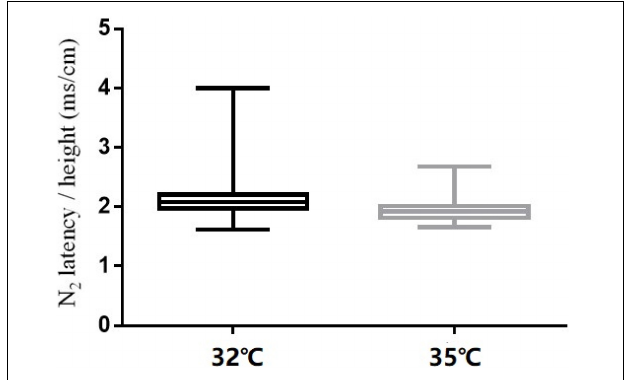
FIGURE 4 | N 2 latency/height at the right forearm for different baseline temperatures (32 and 35 ◦ C).